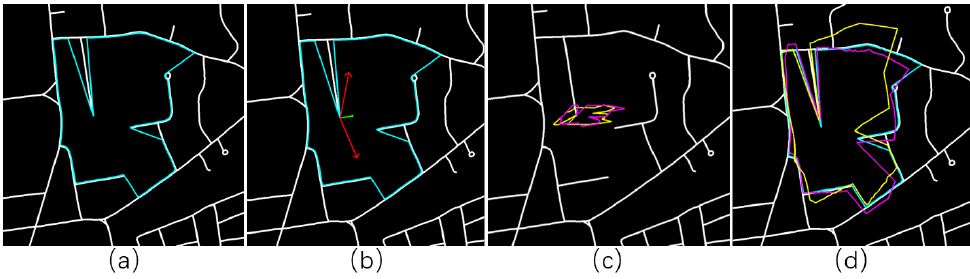
Figure 3. Compute the PICF descriptor. ( a ) The contour point set is collected by finding the closest points in each direction interval; ( b ) the centroid of the whole contour and two centroids of the half-contours are calculated, which are shown in green and red, respectively; ( c ) the contour is aligned with two affinity transformations, respectively, which is estimated by aligning the centroid of the whole contour and the centroids of the half-contours to given points; the two aligned contours are shown in pink and yellow, respectively; ( d ) the two contours reconstructed from the PICF descriptors are shown in pink and yellow, respectively, and the original contour is shown in light